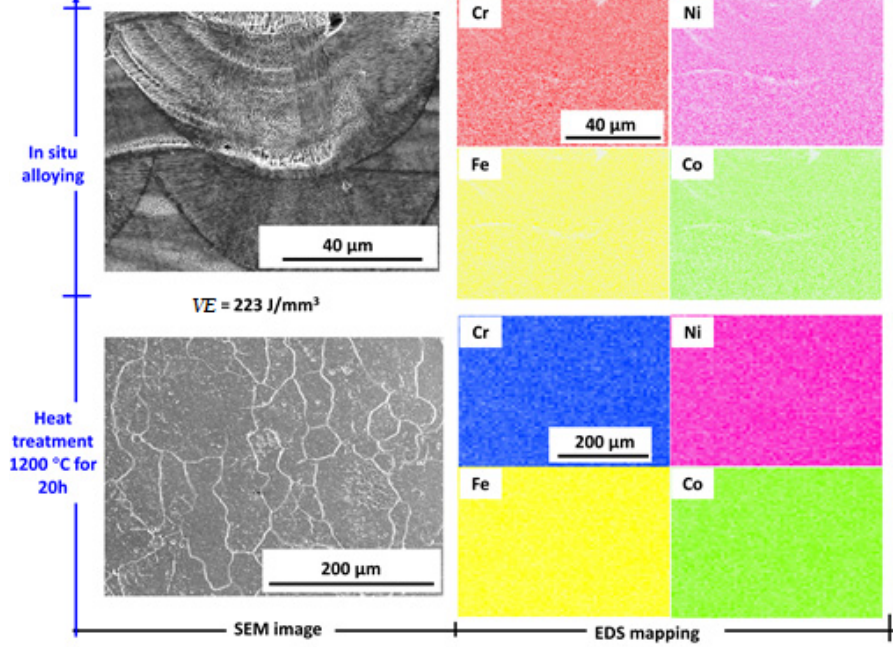
Figure 12. SEM and EDS mapping image of printed samples with elemental powder blend and post-heat-treated samples.